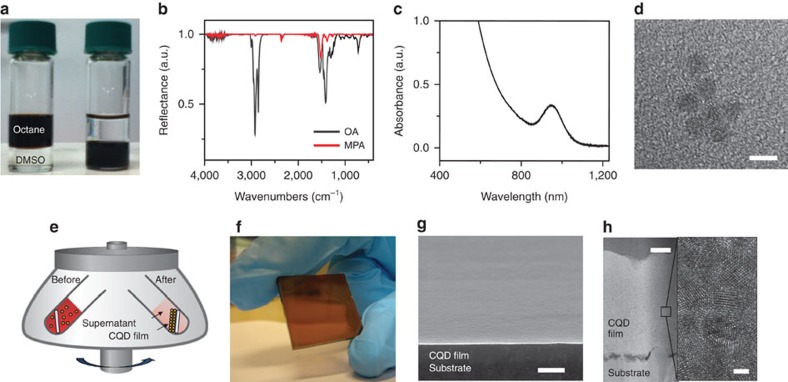
Direct formation of CQD solids via centrifugal casting of CQD ink.(a) Photograph showing the ligand exchange process of OA–PbS CQD solution with MPA molecules. Red coloured colloidal dispersion of OA–PbS CQDs undergoes the phase transfer from octane (left) to DMSO (right) on exchange of the original organic surface ligands with MPA. (b) Fourier transform infrared spectra of PbS CQDs capped with the original OA ligands (black), and with MPA ligands (red). (c) Absorption spectrum of 3.3 nm PbS CQDs capped with MPA ligands dispersed in DMSO. (d) TEM image of 3.3 nm PbS CQDs capped with MPA ligands. Scale bar, 5 nm. (e) Schematic diagram showing the centrifugal casting method to fabricate CQD films. Before centrifugation, substrate is inserted and fixed in a centrifuge tube held at ∼30° containing suspensions of CQDs in DMSO. During the centrifugal rotation, particles in the suspension start to settle out of the fluid in which they are entrained, and assemble on the substrate. After complete sedimentation of particles, the supernatant liquid is carefully decanted from the tube without disturbing the CQD precipitate. (f) Photograph of MPA-exchanged PbS CQD film via centrifugal casting method. (g) Scanning electron microscopy (SEM) shows that films are crack-free and macroscopically uniform over large areas. Scale bar, 500 nm. (h) A cross-sectional TEM image of a MPA-exchanged 4 nm PbS CQD film sample prepared by focused ion beam milling (left). Scale bar, 100 nm. Magnified TEM image of the MPA–PbS CQDs film (right). Scale bar, 2 nm.